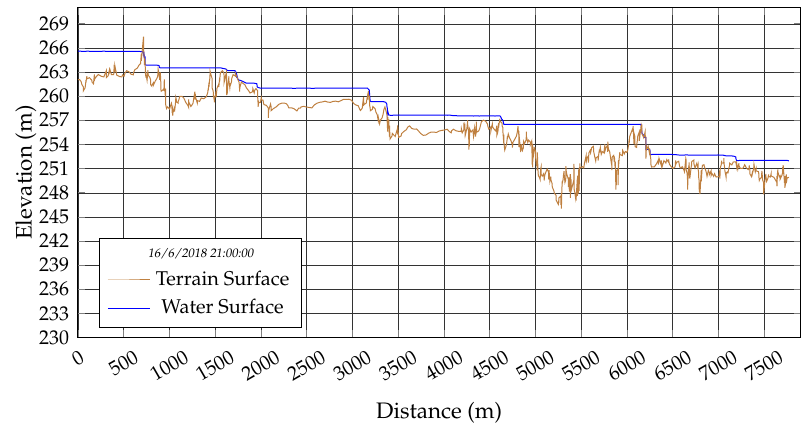
Figure 12. Longitudinal profile of the ground surface and the water surface. Pump location for the scenario 5.